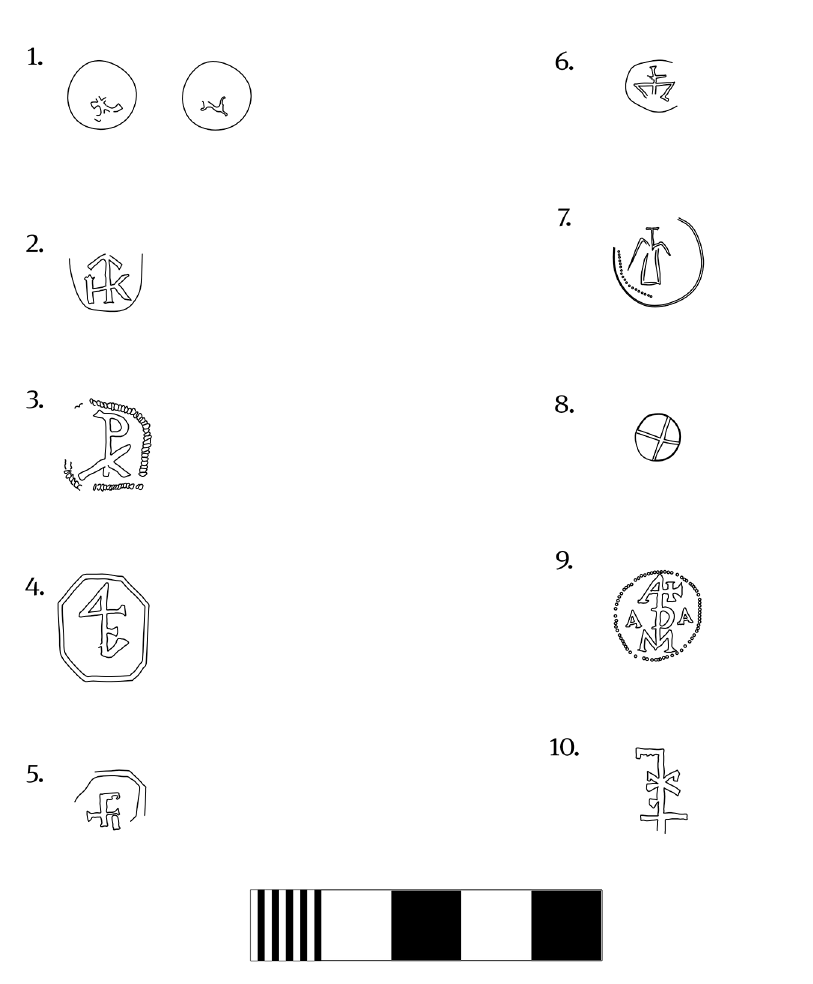
Figure 31. Privy marks from lead seals originated from: Gdańsk (1, 2), Grabów (3, 4), Lampartopol (5), Leszno (6), Nysa (7), Wolsztyn (8), Wschowa (9) and Zbąszyń